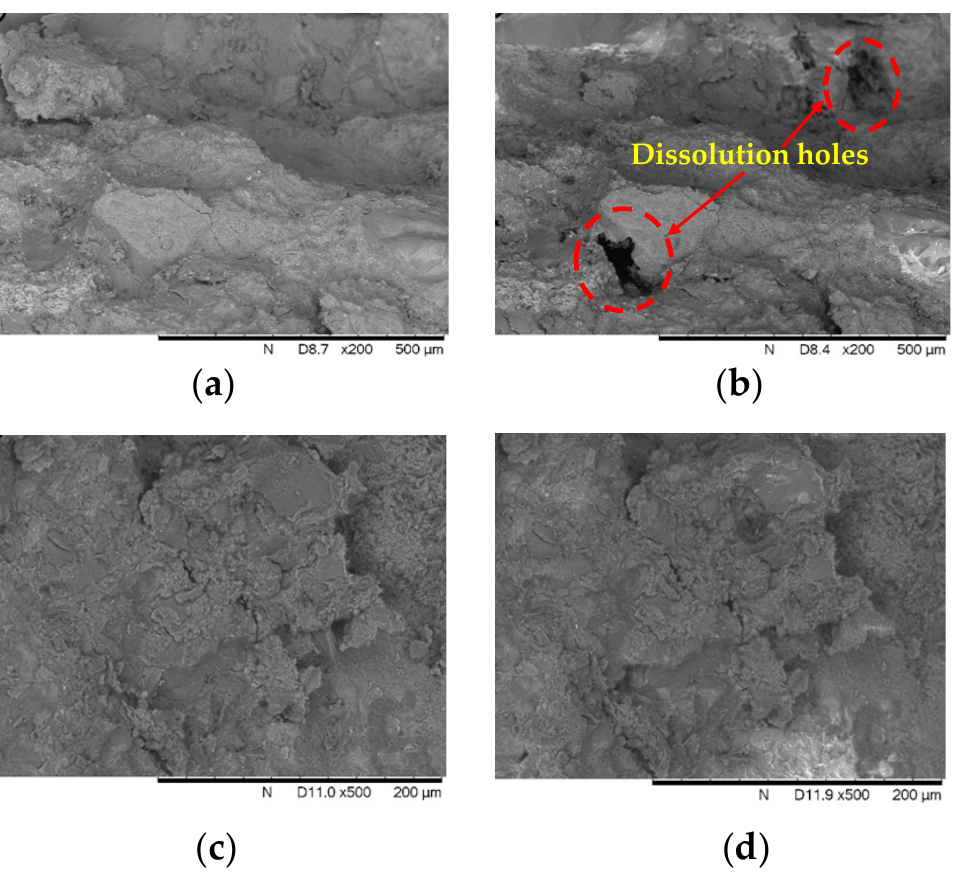
Figure 9. SEM comparison of rock before and after the reaction. ( a ) C7 sample before the reaction. ( b ) C7 sample (Dissolution hole). ( c ) S1 sample before the reaction. ( d ) S1 sample after reaction (No big